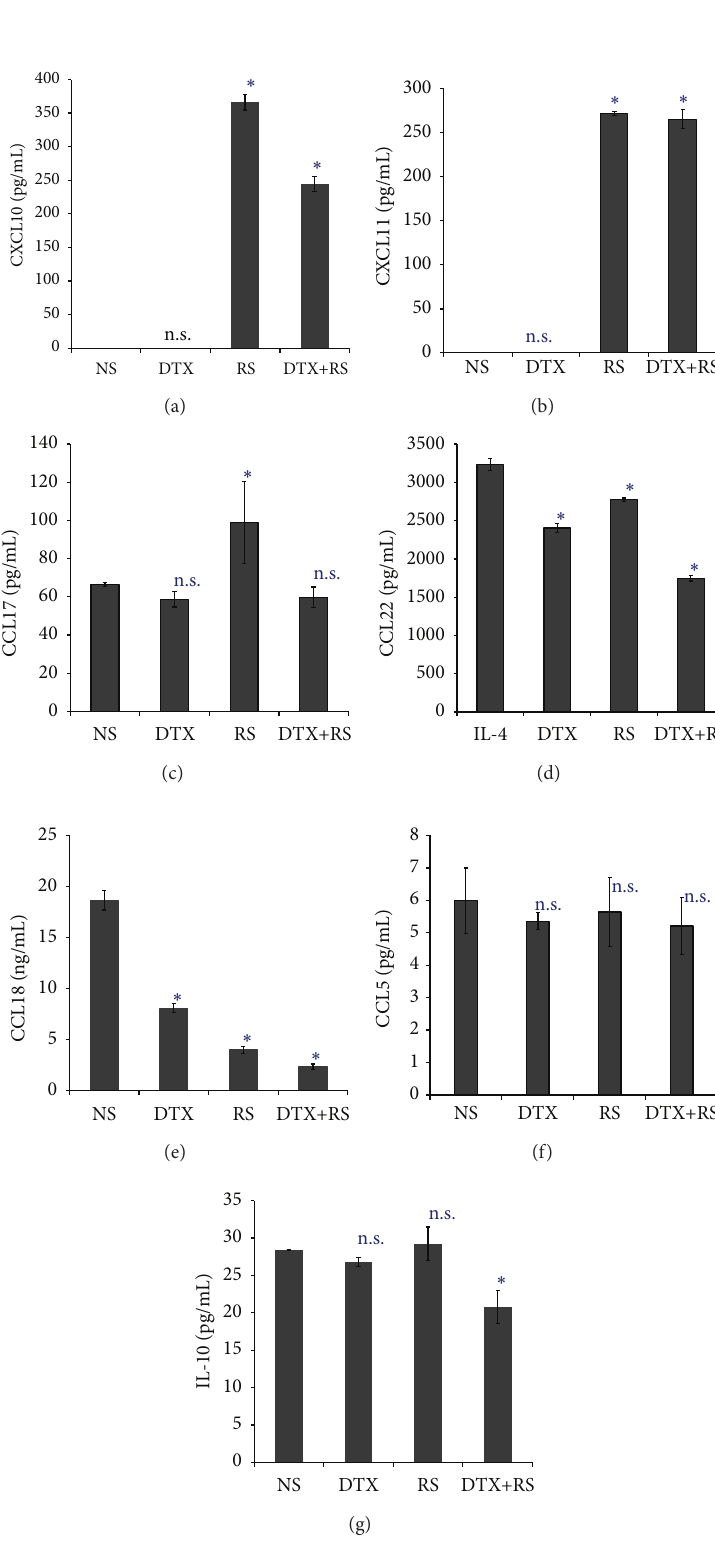
Figure 3: DTX with or without RS effects on the production of CXCL10, CXCL11, CCL17, CCL18, CCL22, and IL-10. The culture supernatants of M2 macrophages stimulated with DTX and/or RS were collected at 48h after culture. Their chemokine and cytokine production was measured by ELISA. Representative data from at least three independent experiments are